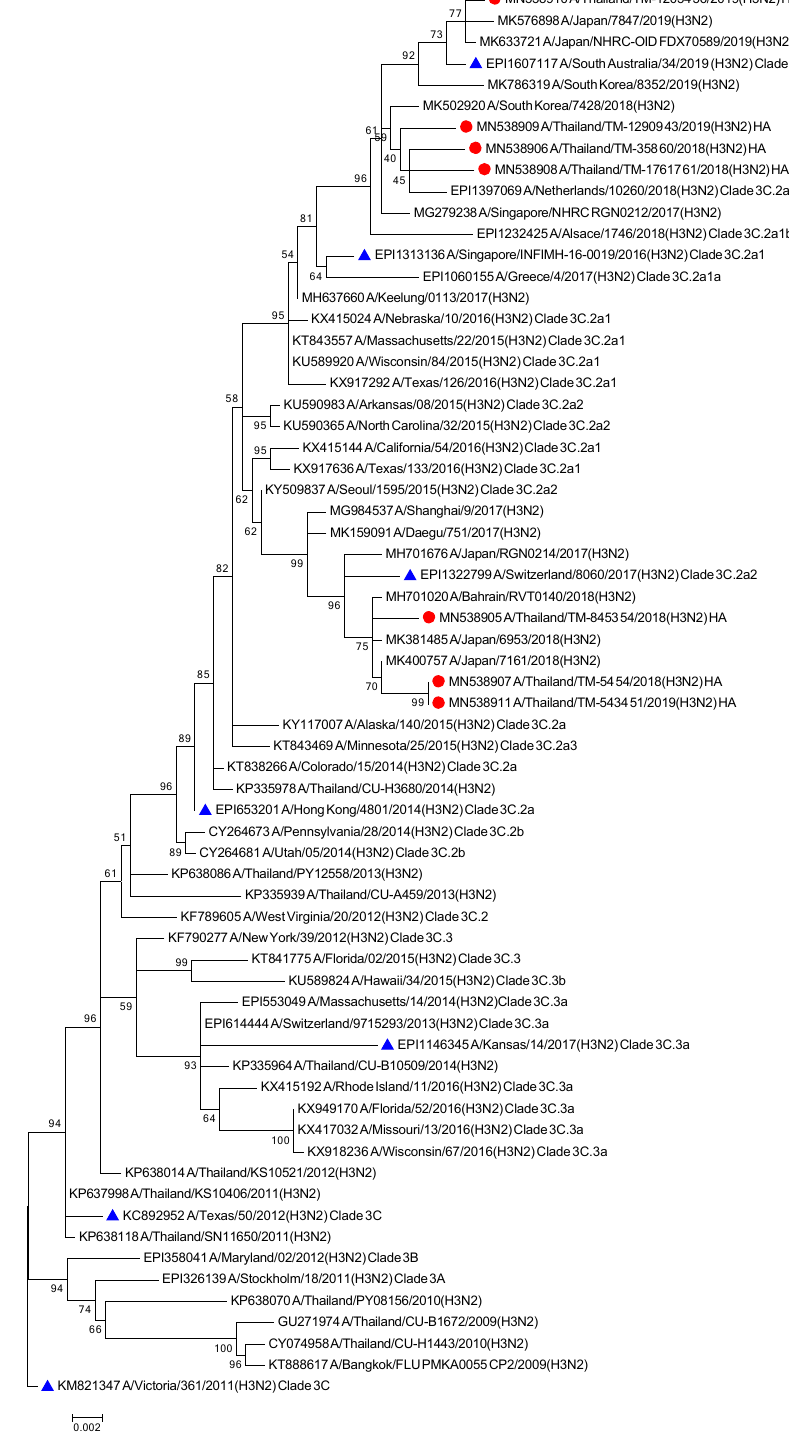
Figure 4. Phylogenetic tree of concatenate from all 8 genes of influenza A/H3N2 Thai strains was inferred by using the Maximum Likelihood method based on the Tamura 3-parameter model. Red circles indicate A/H3N2 Thai isolates and blue triangles indicate A/H3N2 vaccine strains